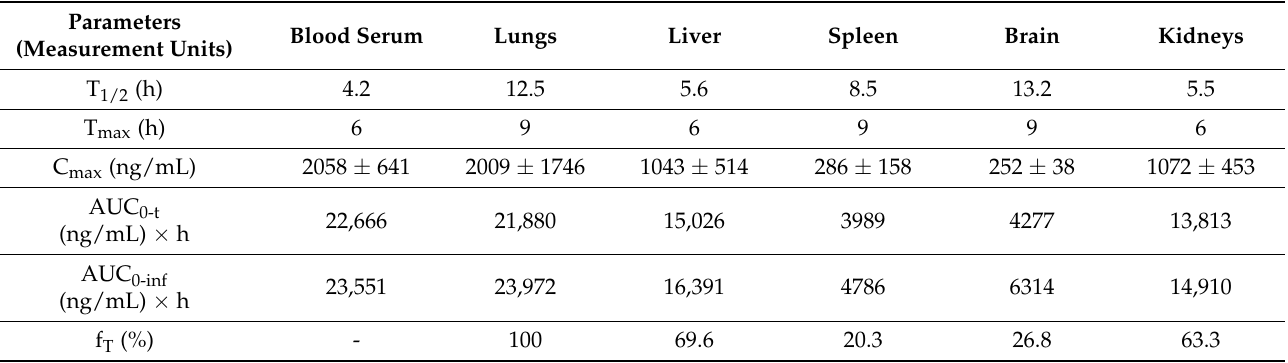
Table 4. Pharmacokinetic parameters of the active metabolite ST-246 in mouse serum and organs upon single-dose oral administration of NIOCH-14 (50 µ g/g).